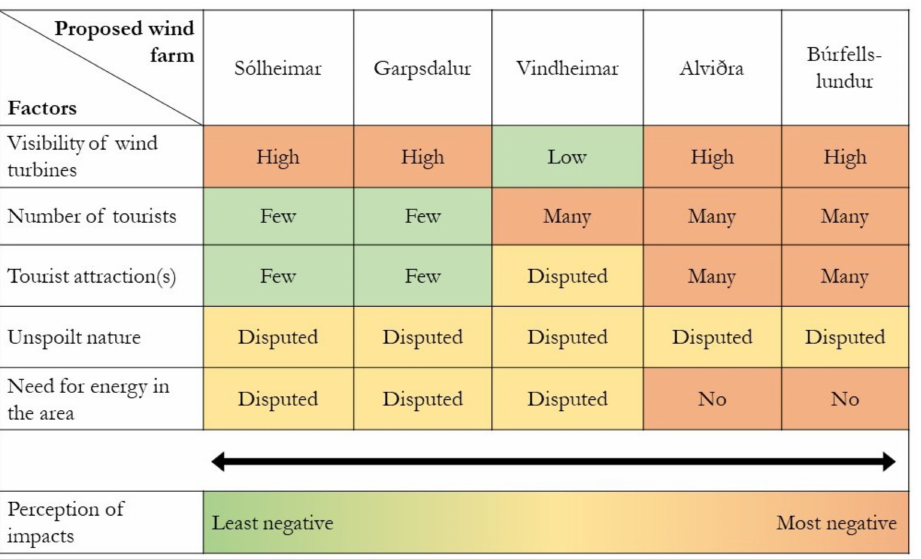
Figure 2. The tourism industry’s ranking of the proposed wind farms according to their impacts on nature-based